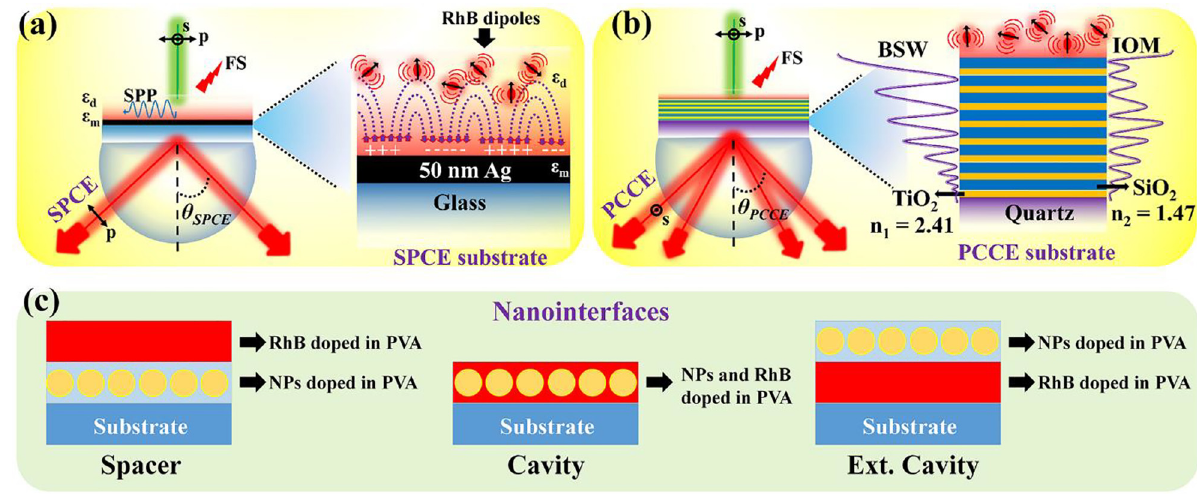
Figure 1: Conceptual schematic of coupling of emission with (a) propagating surface plasmon polaritons (SPPs) of metal thin fi lm (with θ SPCE as the angle of emission)and (b) surface-trapped modesof 1DPhC(with θ PCCE as angleof emission). The magni fi ed imageson the right sideof (a) and (b) display the coupling at the nanointerface. (c) Schematic representation of spacer, cavity and ext. cavity nanointerfaces. Additional details are presented in Supplementary